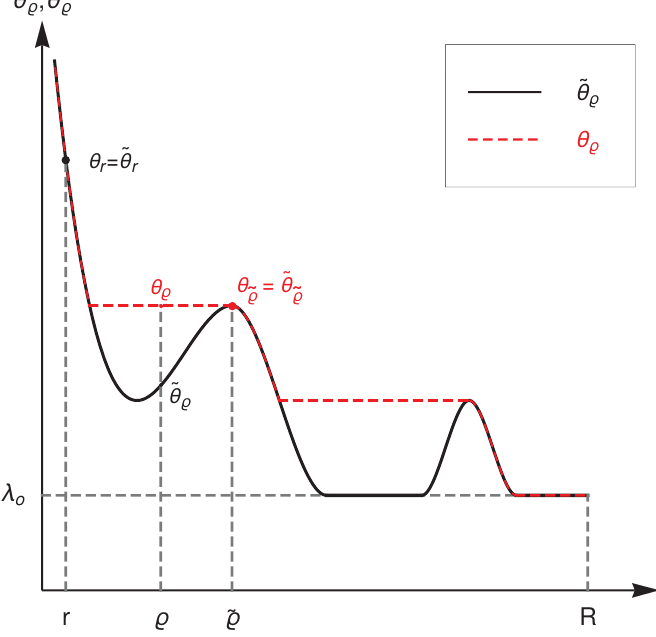
Figure 1: Illustration of the rising sun